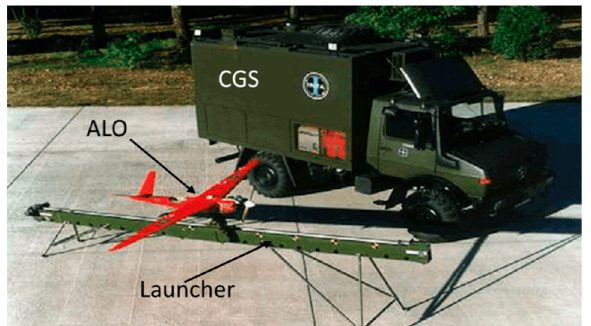
Figure 3. Completed ALO (Avión Ligero Observación) system: Control ground station, rubber bungee launcher, and aerial aircraft.